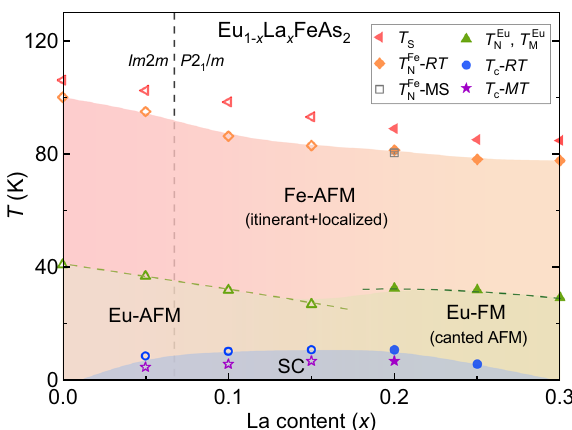
0.0 Fig. 6 Electronic phase diagram of Eu 1 − x La x FeAs 2 . The structural, Fe-AF, Eu-related magnetic, and superconducting transition tem- peratures as functions of the nominal La doping content x for the polycrystalline samples. The open symbols for x ≤ 0.15 represent the data extracted from our previous work 11 , and the solid symbols for x ≥ 0.15 the data obtained in the present work. The structural transition temperatures ( T S ), the Fe-AF transition temperatures (cid:3) (cid:4) (cid:2) RT T Fe , and the superconducting transition temperatures N ( T c − RT ) are obtained from the transport measurements. The Fe- (cid:3) (cid:4) (cid:2) MS AF transition temperature T Fe for x = 0.2 is obtained from N the Mössbauer spectroscopy investigation, where the error bar represents the s.e.m. The Eu-magnetic transition temperatures (cid:3) (cid:4) and T Eu T Eu and the diamagnetic transition temperatures N M ( T c − MT ) are obtained from the magnetization measurements.